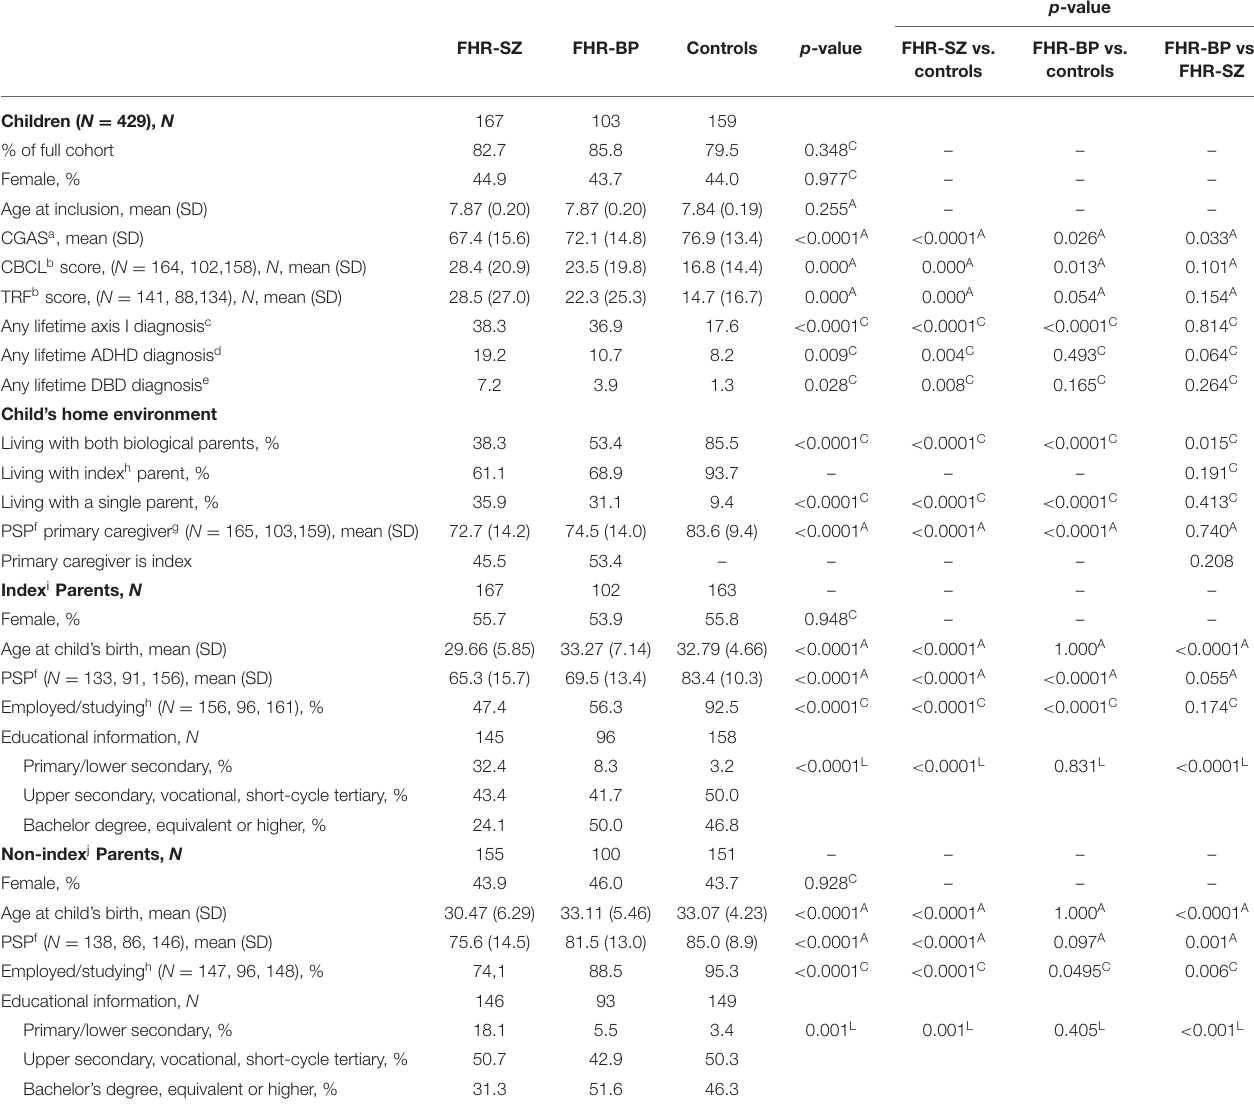
TABLE 1 | Characteristics of children in the Danish high risk and resilience study with an SDQ-P, their home environment, and their biological parents.